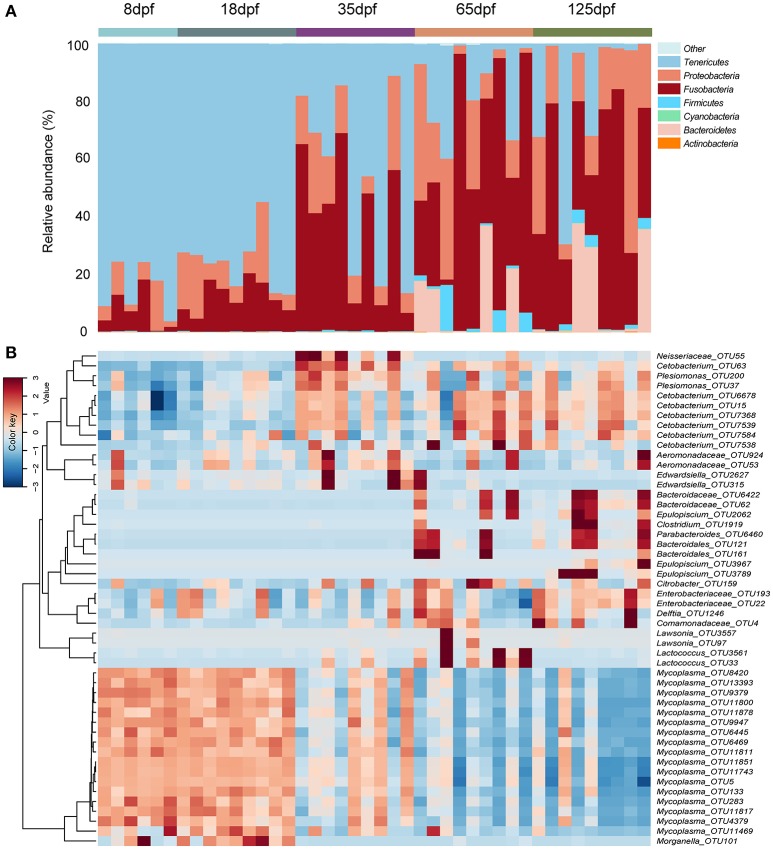
Compositions of bacterial community in the gut obtained from individual southern catfish at different host ages. (A) The microbiota is shown at the phylum level as bar graphs. (B) A heat map with the abundance of top 50 OTUs is represented. Bars are labeled by host age, with 8, 18, 35, 65, and 125 dpf representing southern catfish individuals collected at the ages 8, 18, 35, 65, and 125 dpf, respectively.